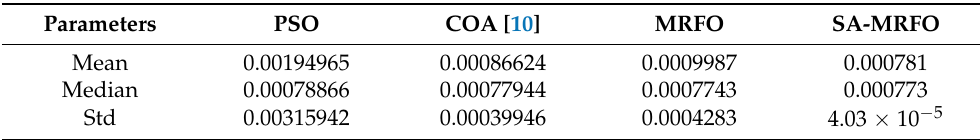
Table 6. Comparison of statistical results of different algorithms.